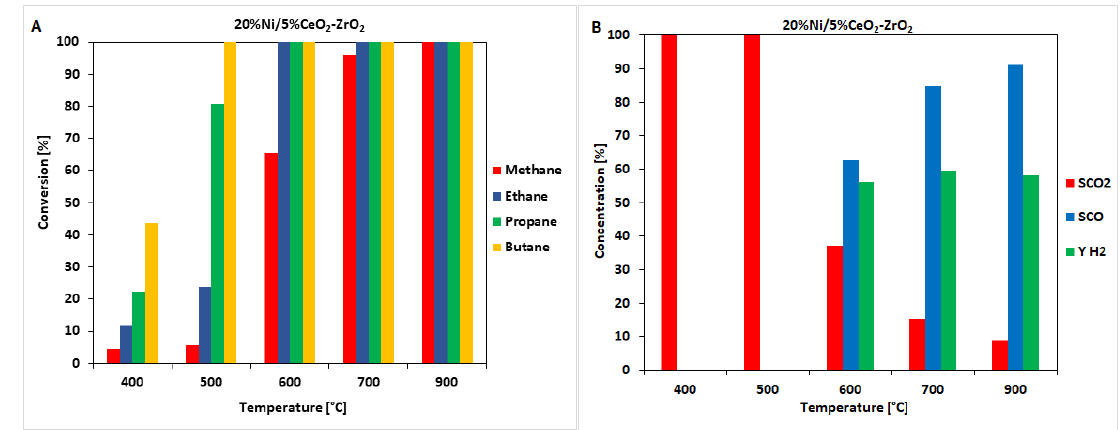
Figure 4. Results of the catalytic activity measurements performed in the temperature range 400–900 °C in the OSRM of the LNG reaction on a 20%Ni / 5%La 2 O 3 -ZrO 2 catalyst. ( A ) Hydrocarbon conversion. ( B ) The selectivity of CO and CO 2 and hydrogen yield.